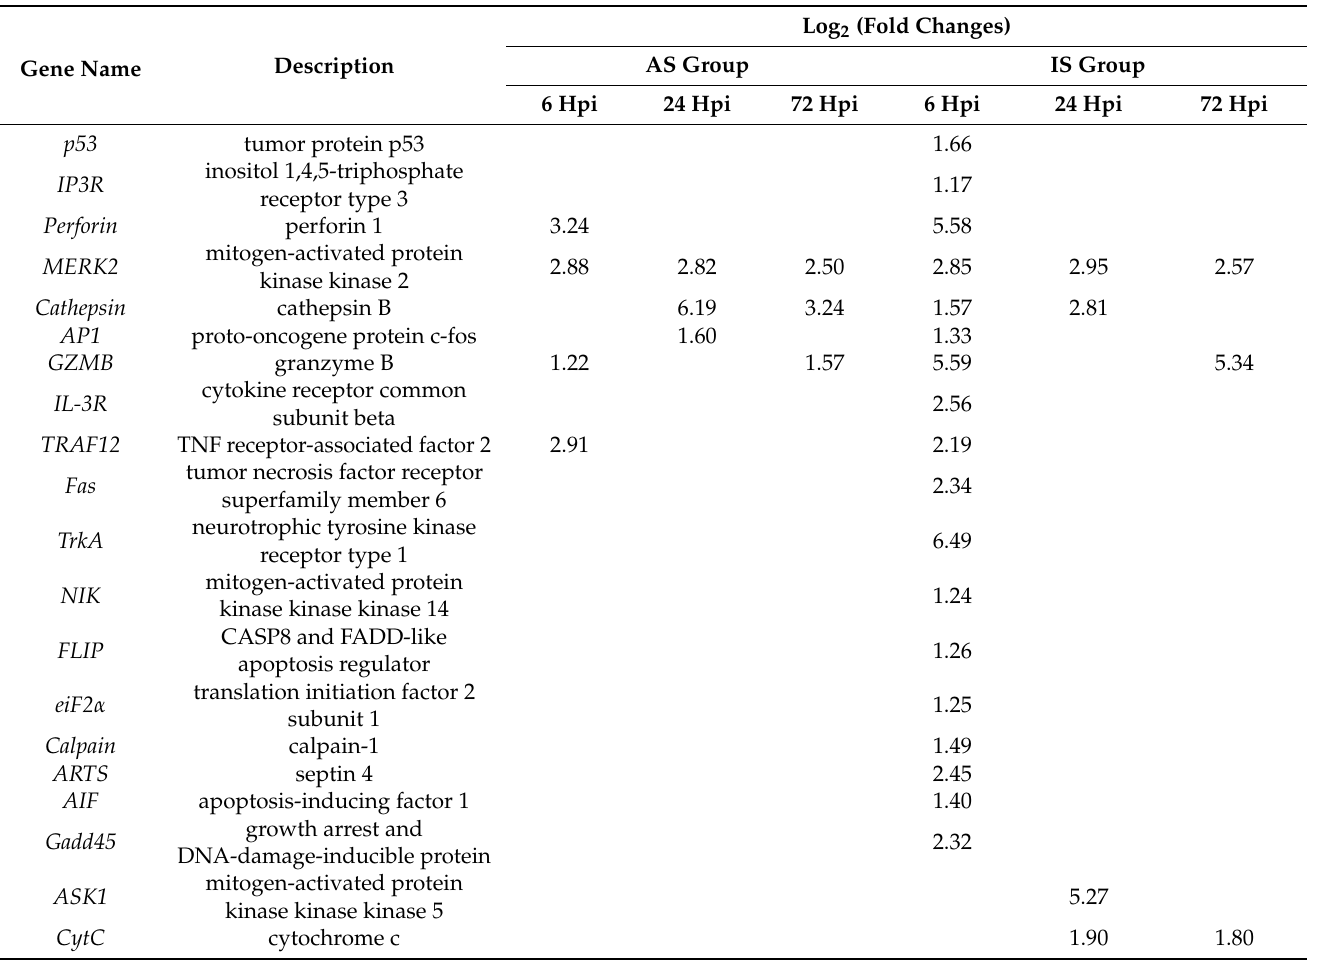
Table 6. Fold changes of up-regulated apoptosis-related genes in the AS group and the IS group compared to the